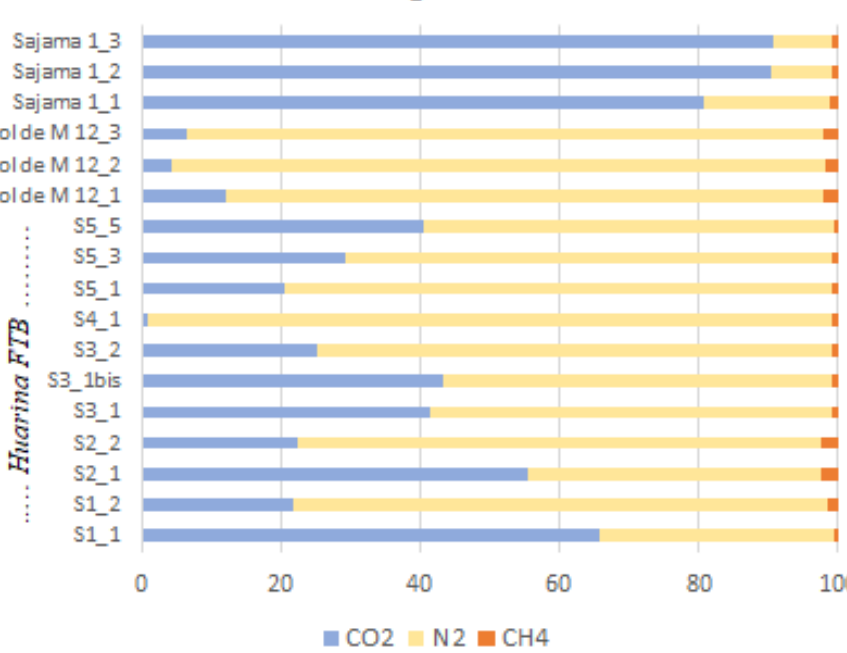
Figure 6. Sajama area: ( a ) satellite view of the zone with the location of the studied areas. ( b ) Details of one of the bubbling pools on the site Saj_1. There are numerous hot springs that lead to green vegetation growth in this high, about 4160 m, and desertic area. The gas is a blend of CO 2 /N 2 and is very CO 2 rich. Table 4. Field and GC values in the Sajama area.